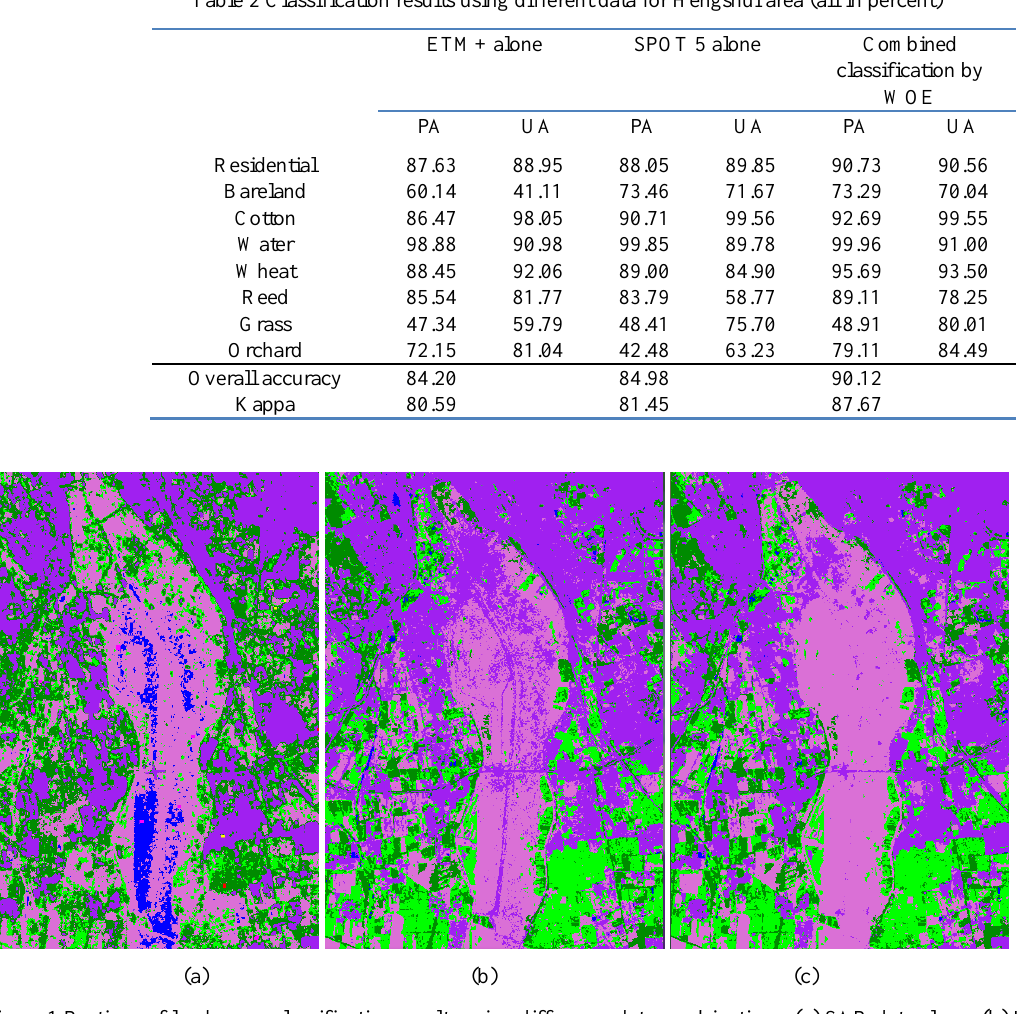
Table 2 Classification results using different data for Hengshui area (all in percent)